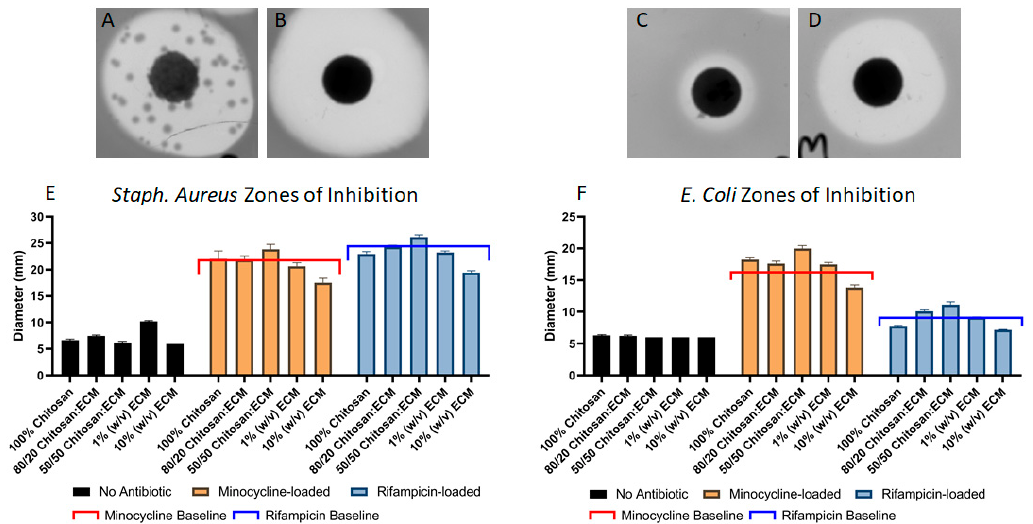
Figure 2. Direct antimicrobial effects of different chitosan:ECM scaffold formulations. ( A ) zone of inhibition of Staphylococcus Aureus bacteria exposed to rifampicin test disc showing presence of rifampicin resistant colonies; ( B ) zone of inhibition of Staph. Aureus bacteria exposed to minocycline test discs; ( C ) zone of inhibition of Escherichia Coli bacteria exposed to rifampicin control disc showing resistance to this antibiotic; ( D ) zone of inhibition of E. Coli exposed to minocycline test disc; ( E ) graph showing the measured zones of inhibition when Staph. Aureus were exposed to the different scaffold formulations (red and blue lines show size of the zone of inhibition to the control discs for comparison); ( F ) graph showing the measured zones of inhibition when E. Coli were exposed to the different scaffold formulations (red and blue lines show size of the zone of inhibition to the control discs for comparison).